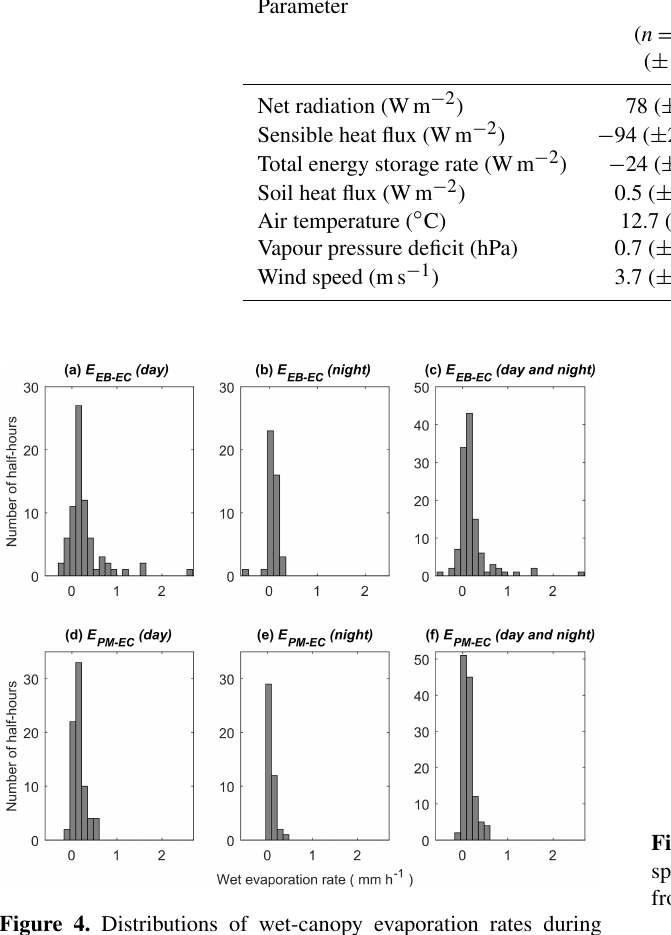
Figure 4. Distributions of wet-canopy evaporation rates during daytime (07:00–19:00UTC + 1), nighttime (19:00–07:00UTC + 1), and combined day and night. Two different methods applied: (a–c) energy balance residual ( E EB − EC ) and (d–f) Penman– Monteith ( E PM − EC ).